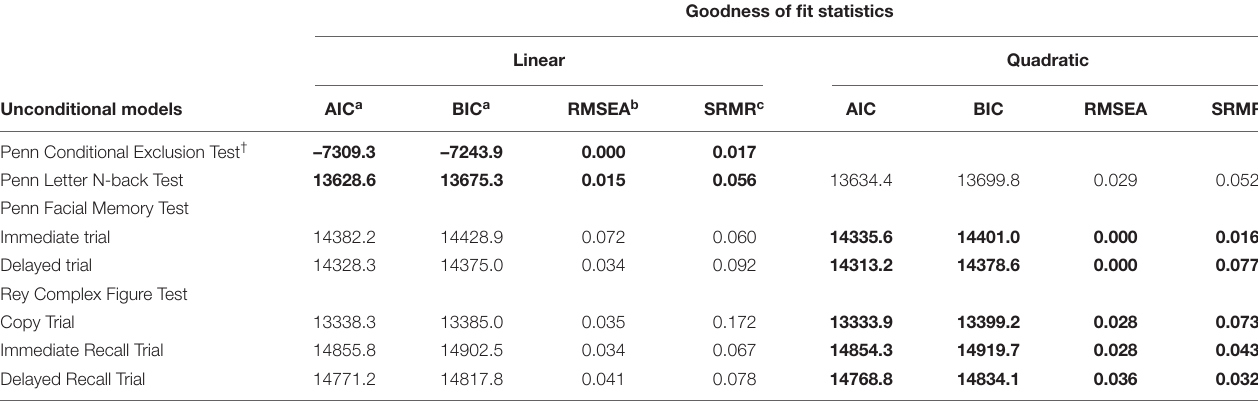
TABLE 2 | Fit statistics for best-fit unconditional